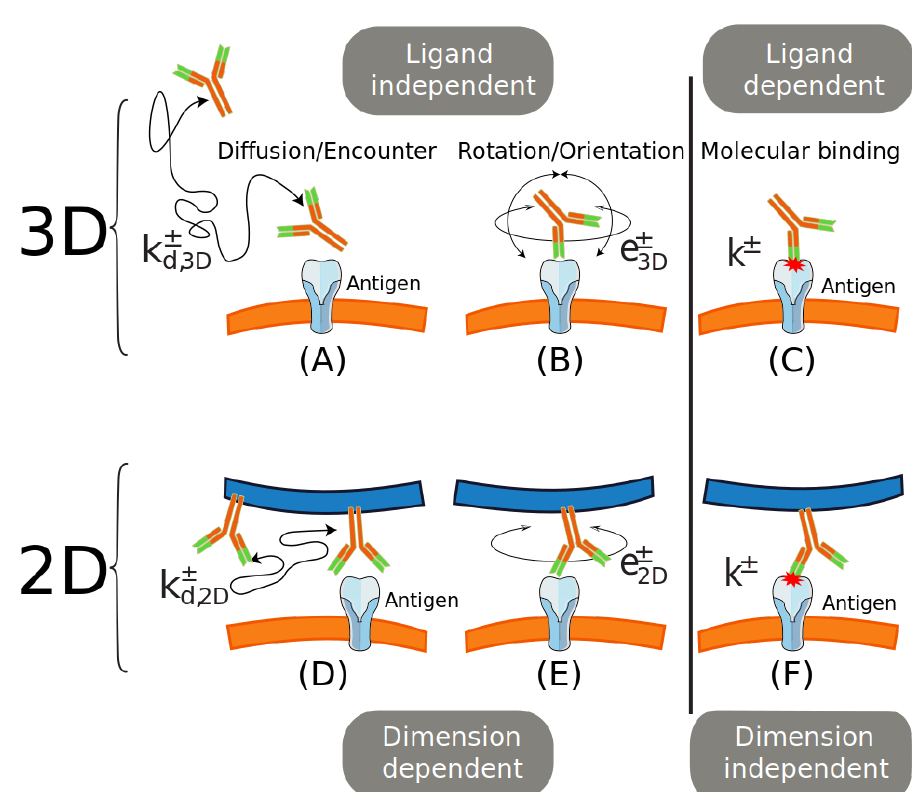
Figure 1. Binding steps in three versus two dimensions. Top row, binding in three dimensions: ( A ) 3D diffusion/encounter, ( B ) rotation/orientation, and ( C ) molecular binding. Bottom row, the three bind- ing steps in two dimensions: ( D ) 2D (membrane) diffusion/encounter, ( E ) rotation/orientation, and ( F ) molecular binding. The vertical line separates dimensional dependent and independent